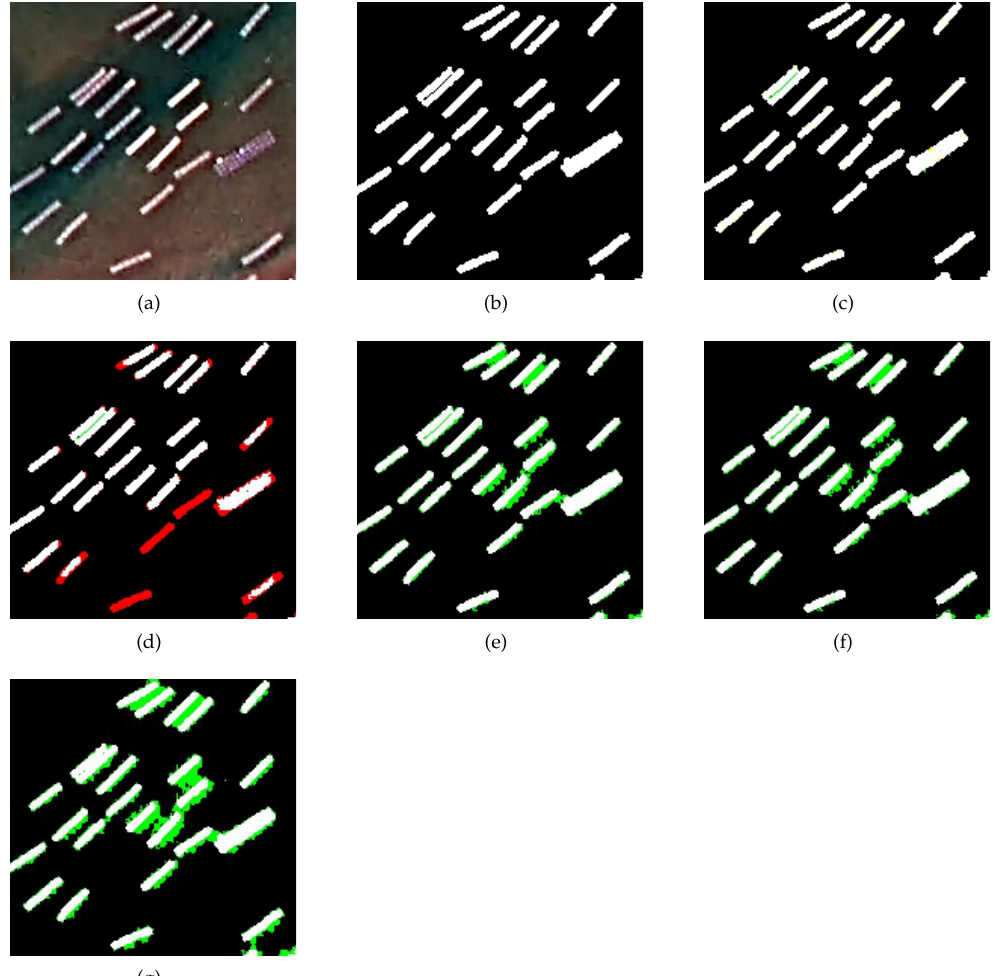
Figure 5. Details of the results of aquatic product extraction carried out by different methods in Region a with a black color denoting background, white color denoting the aquaculture raft, red color denoting the missing extraction, and green color denoting more extraction. ( a ) Original image. ( b ) Ground truth image. ( c ) IEGD (10). ( d ) CEM (3). ( e ) NN [38]. ( f ) SVM [39]. ( g ) MLE